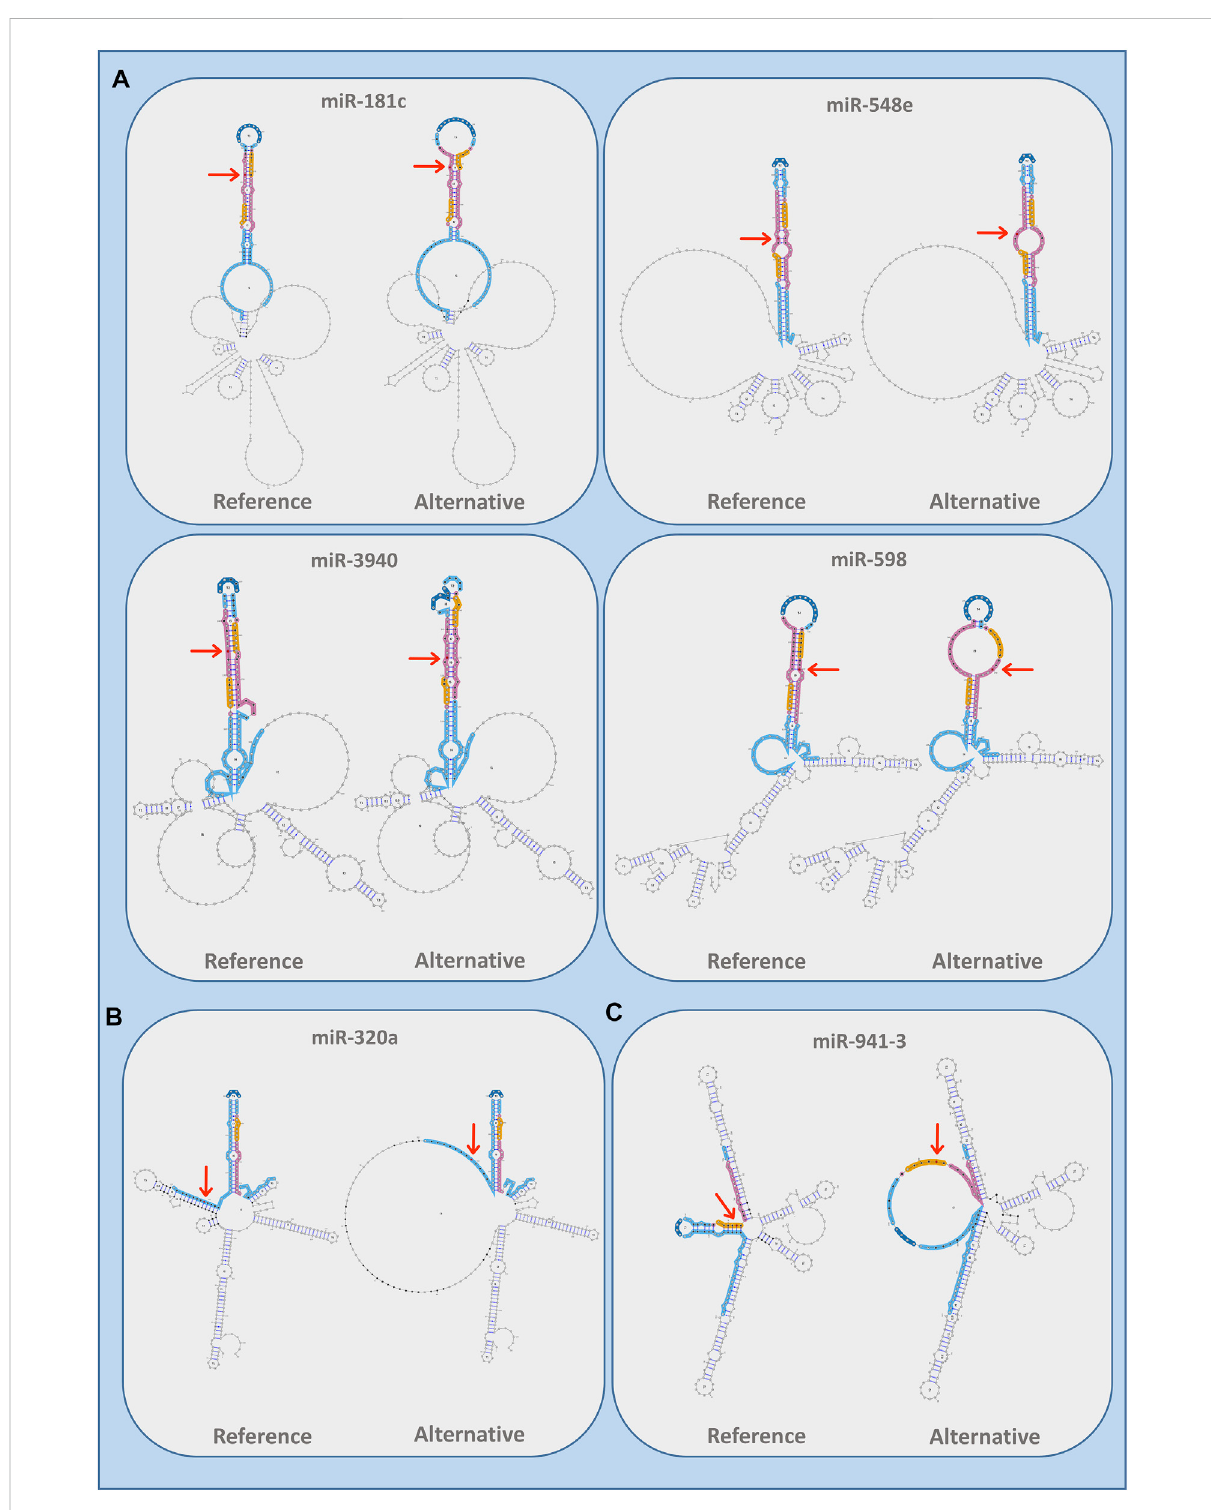
FIGURE 3 ImagesofRNAsecondarystructuresremodeledbythepresenceoftherarevariantsindifferentmiRNAregionsasobtainedbymiRVaSusingthe centroidparadigm. (A) VariantslocatedinmatureregionsofmiR-181c(chr19:g13985554:G > A),miR-3940(chr19:g.6416489:G > A),miR-548e(chr10: g.112748708:C > T),andmiR-598(chr8:g.10892743:C > T); (B) VariantlocatedinarmdomainofmiR-320a(chr8:g.22102548:G > T); (C) Variantlocated in the seed sequence of miR-941-3 (chr20:g.62550965:G > A). The variant is indicated in red by an arrow; miRNA regions are indicated by speci fi c colors: seed (yellow), mature (pink), arms (light blue), loops (blue), and fl anking region